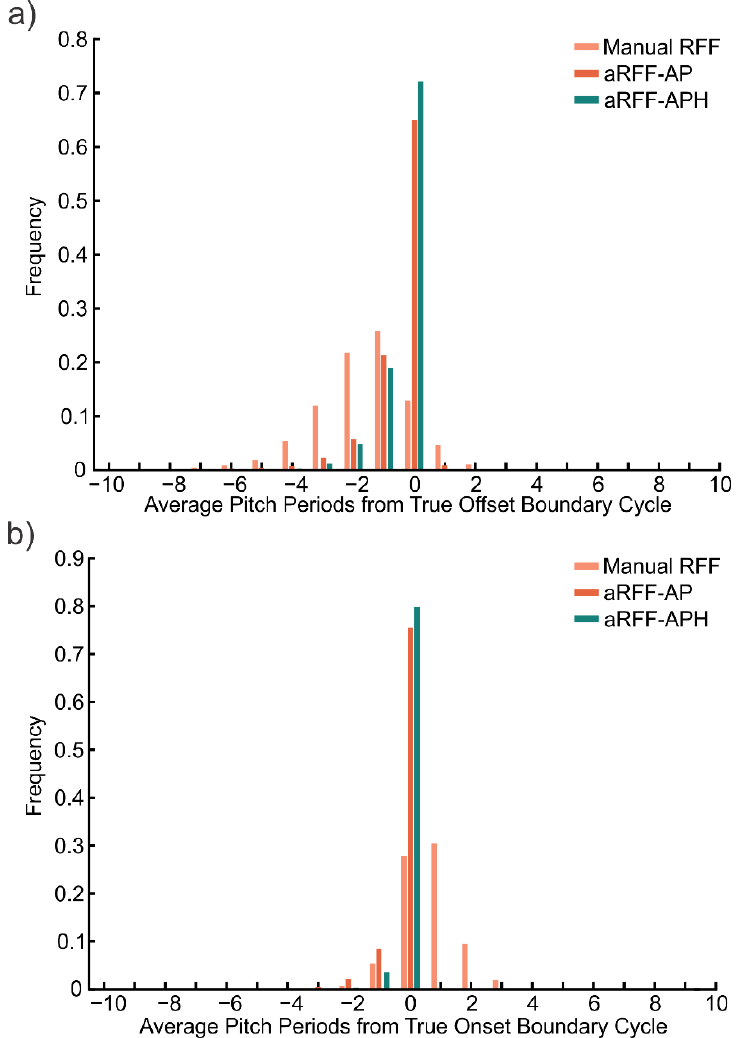
Figure 5. Boundary cycle identification of each RFF estimation method (manual, aRFF-AP, aRFF- APH). For ( a ) voicing offset and ( b ) voicing onset. Results for manual RFF estimation are shown in light orange, aRFF-AP in dark orange, and aRFF-APH in teal.